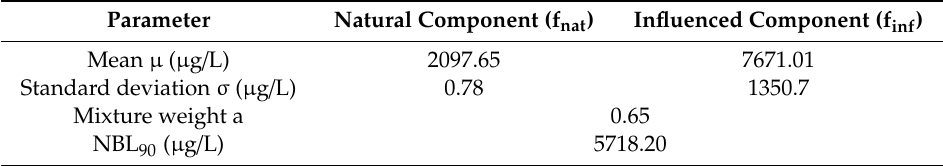
Table 3. GuEstNBL output: Results of the guided estimation procedure for manganese